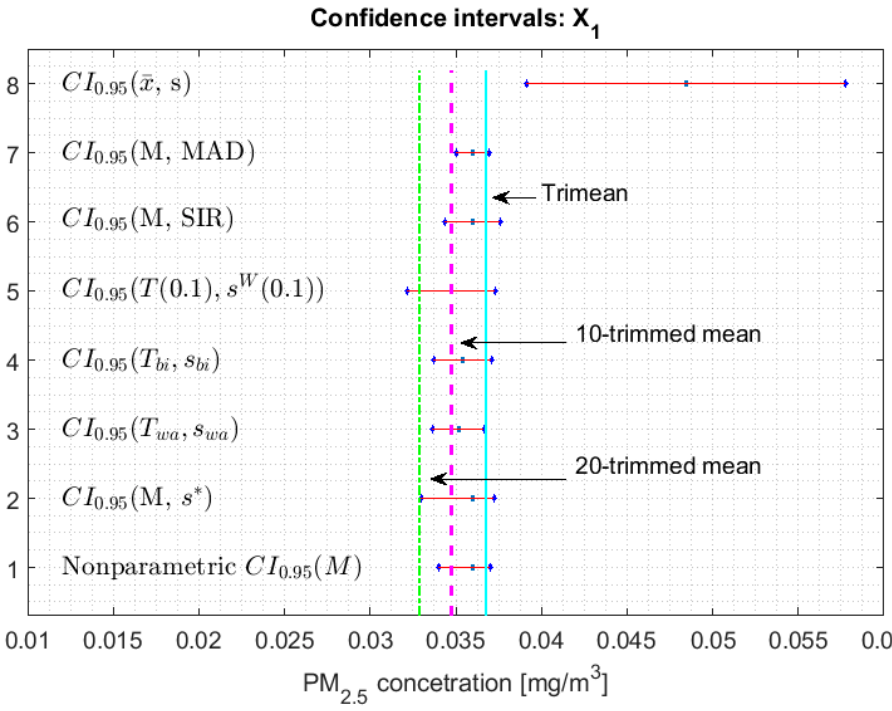
Sensors 2020 , 20 , 654 Figure 2. 95% confidence intervals (𝐶𝐼 (cid:2868).(cid:2877)(cid:2873) ) for robust and non-robust estimators: 𝑋 (cid:2869) . Figure 2. 95% confidence intervals ( CI 0.95 ) for robust and non-robust estimators: X 1 .